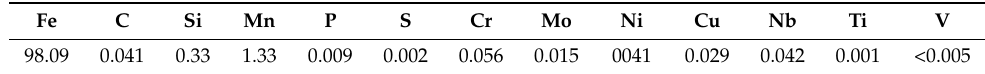
Table 1. Composition (wt.%) of API 5L X65 carbon